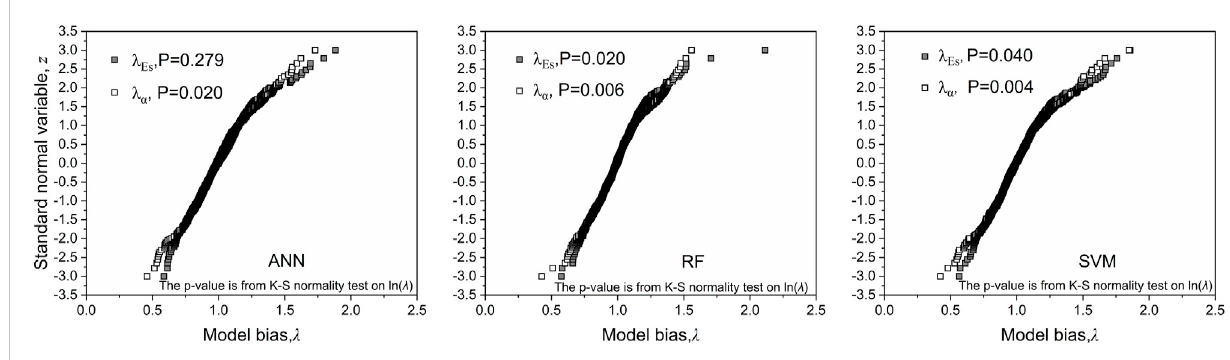
Cumulative distributions and K – S normality test results for the biases of the three ML models.